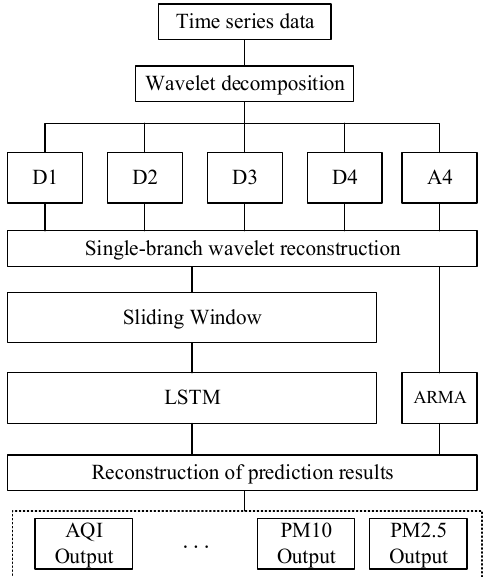
Figure 4. WD-LSTM-ARMA algorithm block diagram.